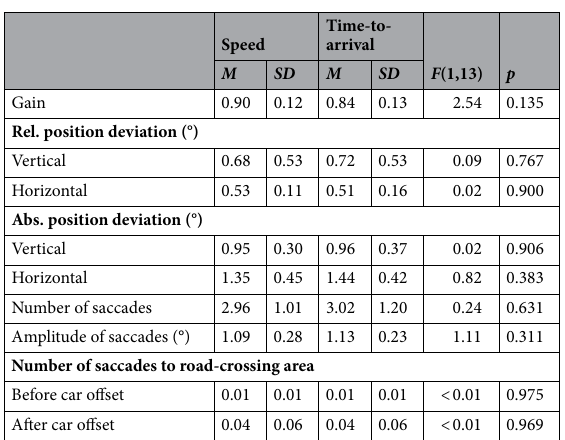
Table 1. Means, standard deviations and F-statistics from univariate comparisons of eye movement